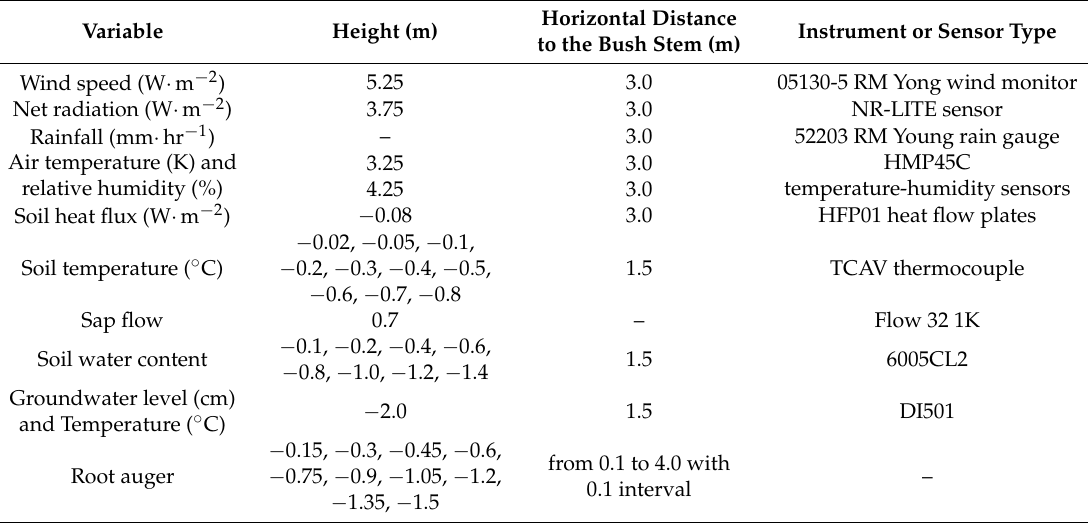
Figure 2. Schematic plot of instrument locations. Table 1. Instruments used at the research site.